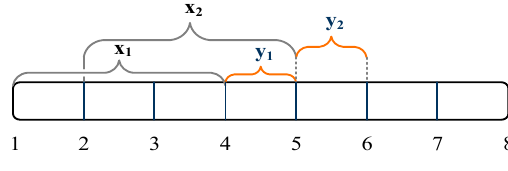
Figure 6. Structure of time-order character.